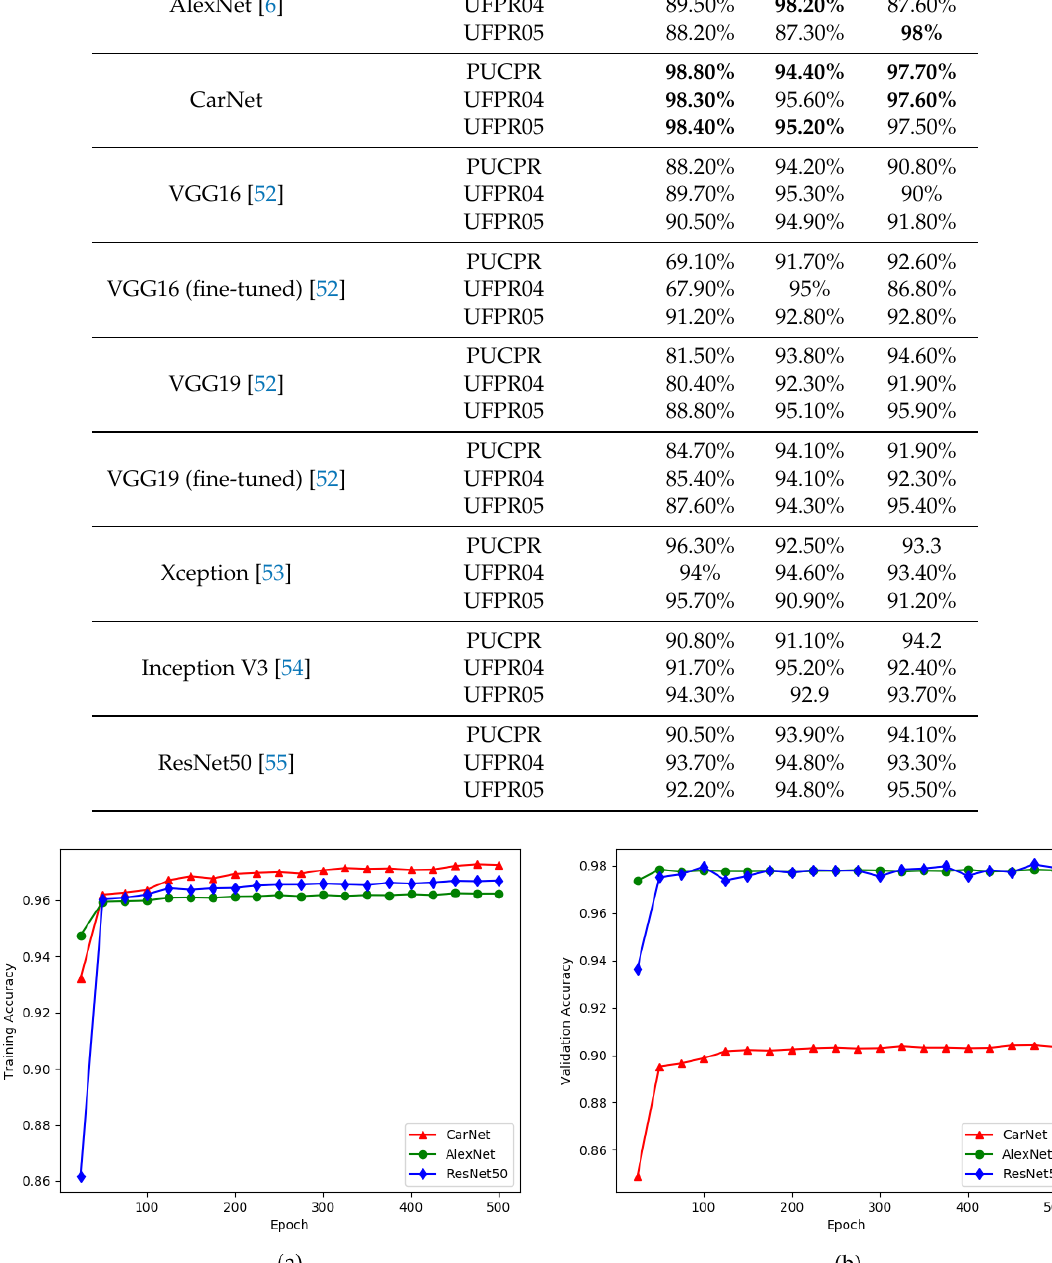
Figure 13. Experimenting on CNRPark + EXT dataset [5] to build an optimal model. x-direction: number of epochs (500), y-direction: accuracy. ( a ) training accuracy; ( b ) validation